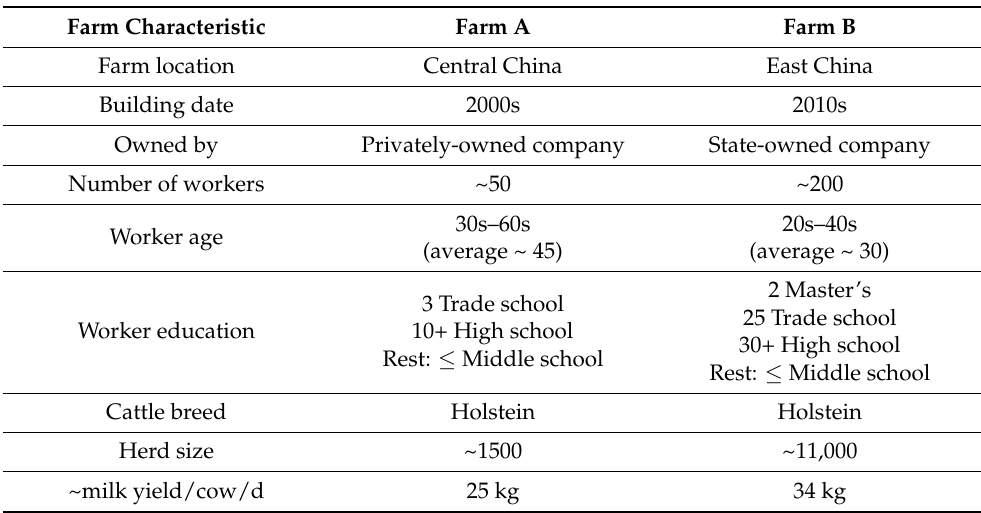
Table 1. General farm information (accurate as of November 2019) for the two Chinese dairy farms used as study